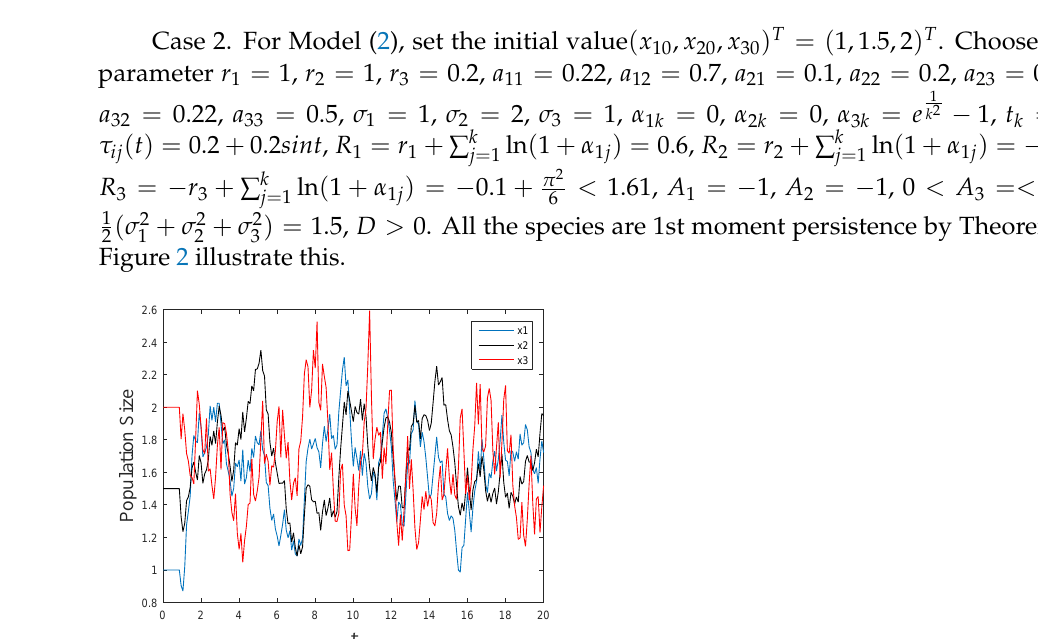
Figure 2. The solution to x i , i = 1,2,3 are 1st moment persistence. In Figure 3, we use the same data from Case 2 to reduce the intensity of white noise, the top predator tends to go extinct. We find that moderate noise intensity is good for the balance of the whole ecosystem. When white noise is too low, it is not conducive to the survival of the top predator.